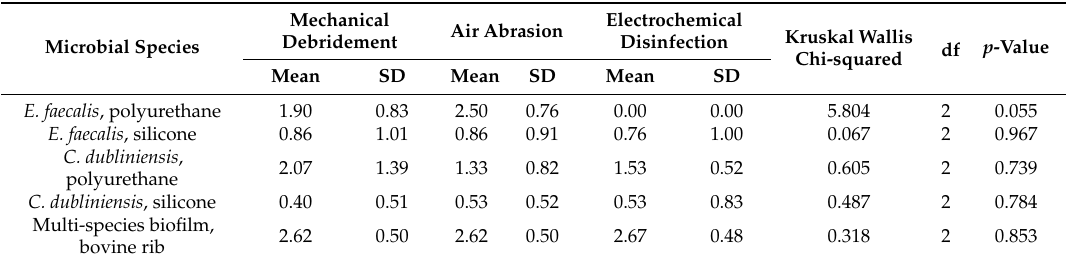
Table 2. Mean values and standard deviations of ratings recorded for implants contaminated with E. faecalis , C. dubliniensis (implants placed in silicone or polyurethane foam) and multispecies biofilm (implants placed in bovine rib) following 5 min of treatment with mechanical debridement, air abrasion and BDD electrode ( n = 3 per microorganism and treatment method). Comparative statistics did not reveal any significant di ff erences among the three modalities ( p > 0.05).